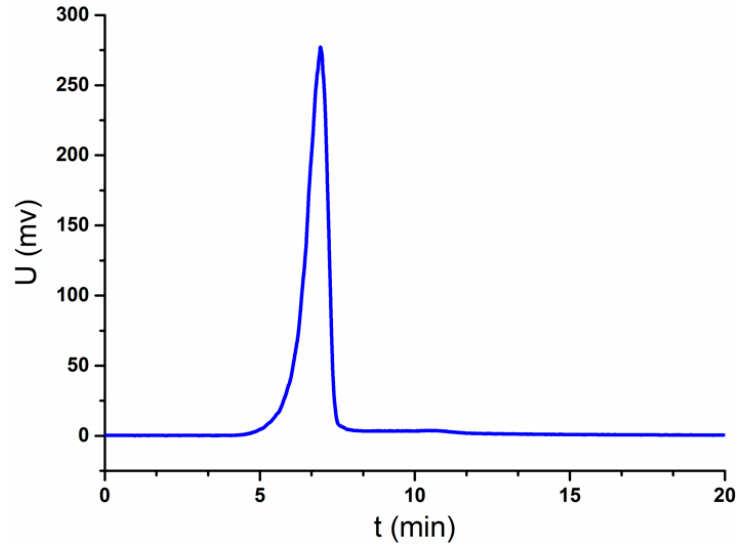
Figure 1. HPGPC-ELSD chromatogram of JC-PS1.